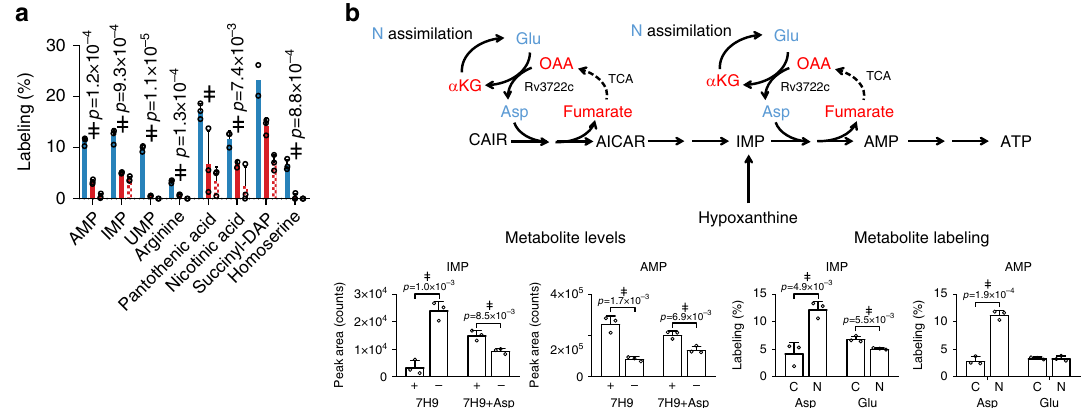
Fig. 8 Rv3722c governs Asp-dependent nitrogen metabolism. a 15 N-stable isotope tracing in Rv3722c-pro fi cient Mtb . Rv3722c-TetON was cultured in 7H9 supplemented with casein hydrolysate, with and without ATC. After a 3 h adaptation to unsupplemented 7H9, 15 N-Asp (blue) or 15 N-Glu (red) was added to the media at a fi nal concentration of 3 mM. After 24 h at 37 °C, 15 N labeling of the indicated metabolites was determined by LC-MS analysis. b Rv3722c serves as a speci fi c nitrogen conduit for de novo purine synthesis. Same as a , but using 15 N- and 13 C-labeled Asp and Glu. Nitrogen containing metabolites are depicted in blue, while their carbon backbones are depicted in red. Data are presented as individual points (open circles) and mean + / − SD of three experimental replicates ( n = 3; but n = 2 for succinyl-DAP 15N-Glu + ATC, due to an analytical interference), representative of two independent replicates. OAA oxaloacetic acid, CAIR carboxyaminoimidazole ribotide, AICAR 5-aminoimidazole-4-carboxamide ribonucleotide. Statistically signi fi cant differences between 15 N-Asp + ATC and 15 N-Glu + ATC were identi fi ed by a combination of a two-sided unpaired Student's t test ( p < 0.05, as indicated) and Mann – Whitney U rank testing (for which the smallest possible p -value for n = 3 is 0.1) (double dagger); Source data are provided as a Source Data fi (Fig. 7b), the ability of more downstream Asp-dependent pro- ducts to augment growth beyond that achieved with Asp alone is a likely indication of a limited fl ux of exogenous Asp through downstream metabolic pathways. Our results nonetheless